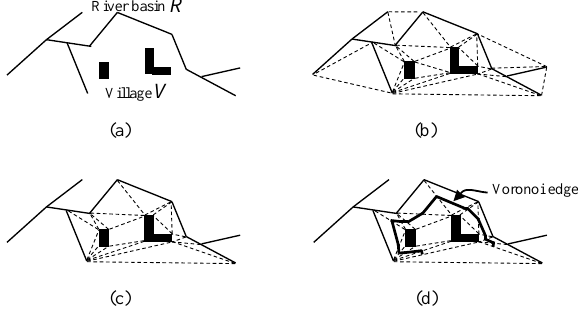
Fig. 8. Procedures of computing direction relations between two Fig.8 Procedures of computing direction relations between two object object groups: (a) generalized object groups; (b) triangulation of groups: (a) generalized object groups; (b) triangulation of the object groups; the object groups; (c) proximal sections of the object groups; and (c) proximal sections of the object groups; and (d) Voronoi Diagram. (d) Voronoi